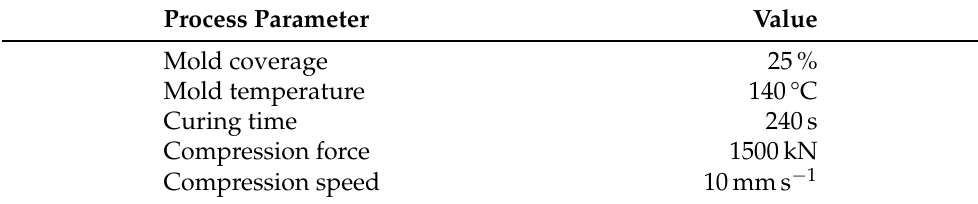
Table A1. Process